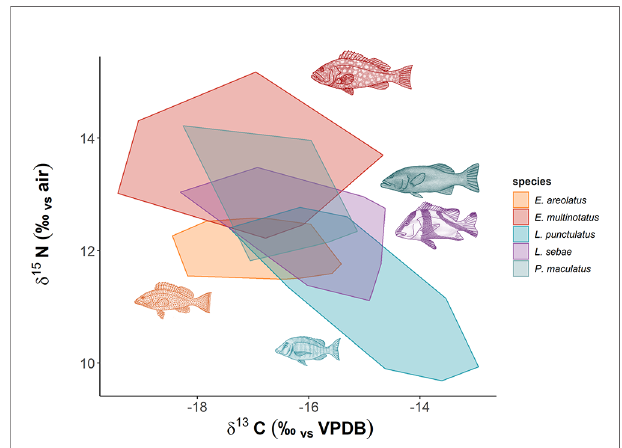
FIGURE 3 | Isotopic niche space of predatory fi sh species. Each minimum convex polygon encompasses all d 13 C and d 15 N values of individuals for each